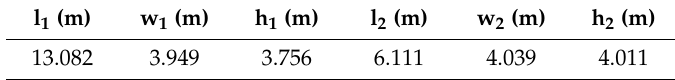
Figure 9. Generation of the B 2 bounding box of the BIM E 2 construction element based on the geometric and topological requirements of the urban environment. Table 4. Maximum dimensions of the bounding boxes B 1 and B 2.